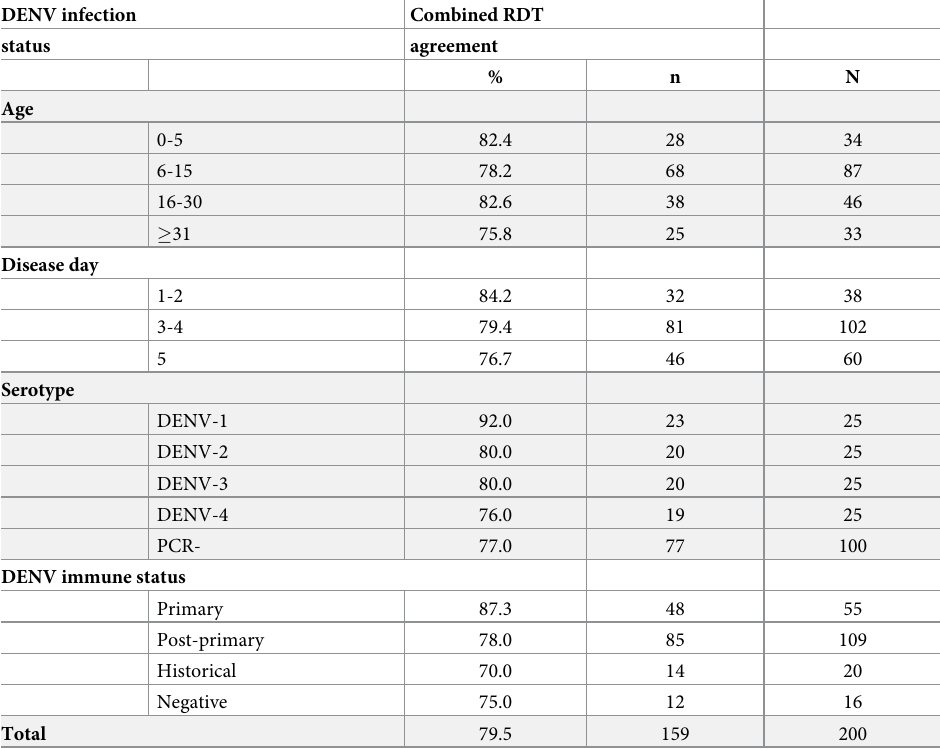
Table 2. Agreement between the estimated and actual combined DENV RDT results of patients in Indonesia.